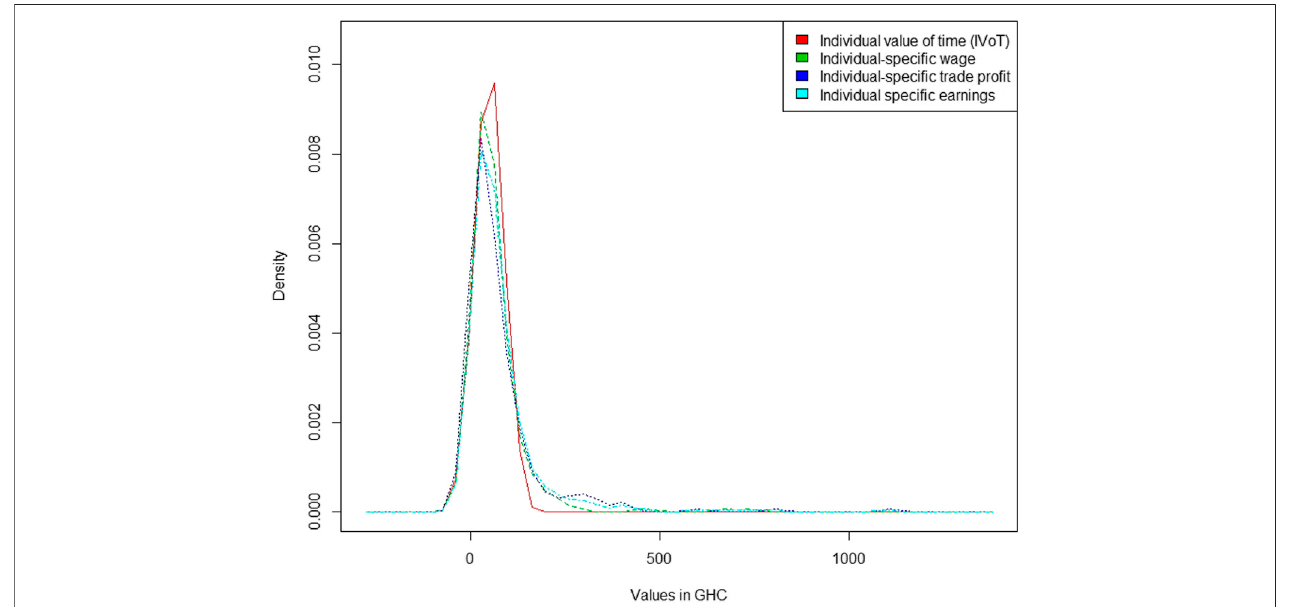
FIGURE 4 | Kernel density plot of Time IVoT and individual-speci fi c wage, trade pro fi t and earning values in the rural study site.